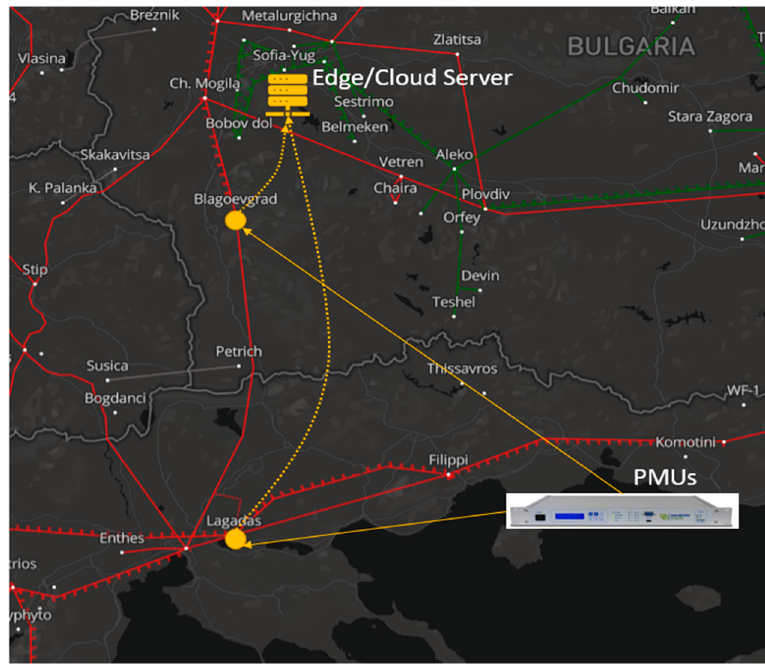
Figure 14. Site architecture of UC4.